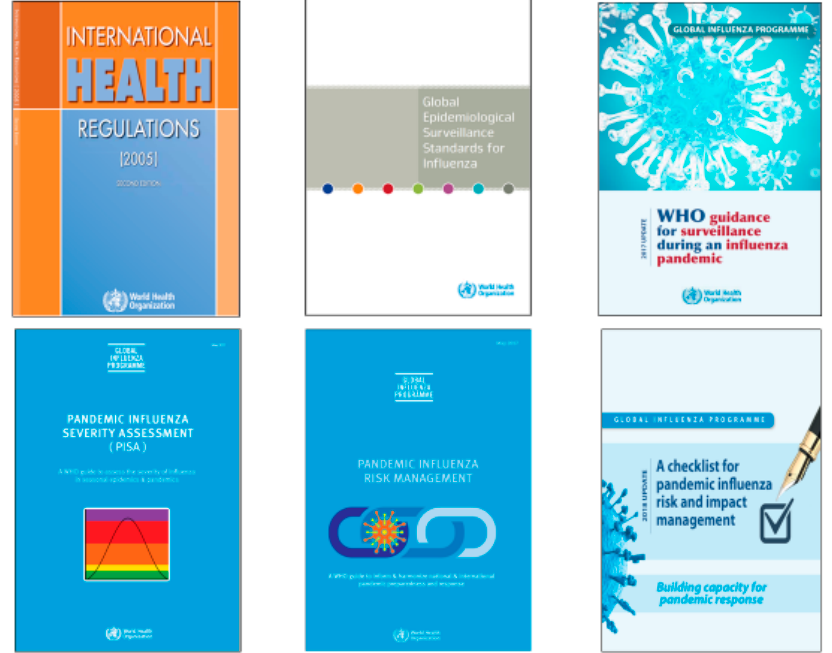
Figure 1. WHO documents which provide clear definitions of the new WHO pandemic phases and give guidance to countries on severity and risk assessment, surveillance procedures, and the essential measures for the determination of national pandemic processes